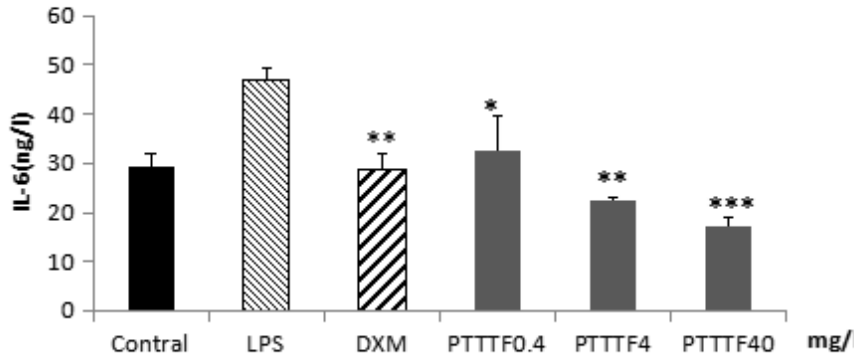
Figure 1: Effect of PTTTF on the content of IL-6 in LPS-induced RAW264.7 cells ( n =3). *: P < 0.05, **: P < 0.01, ***: P < 0.001, compared with LPS group.